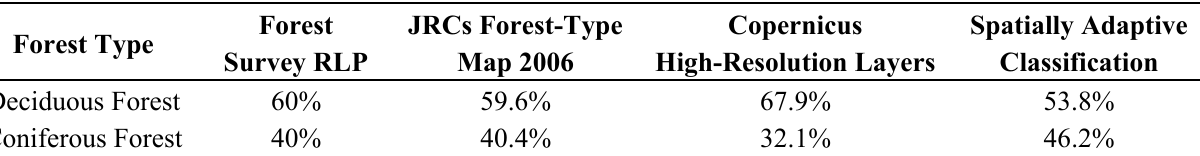
Table 2. Proportional coverage of forest types for Rhineland-Palatinate from official forest survey estimation [78] compared with the JRC forest-type map, Copernicus HRL, and the proposed spatially adaptive